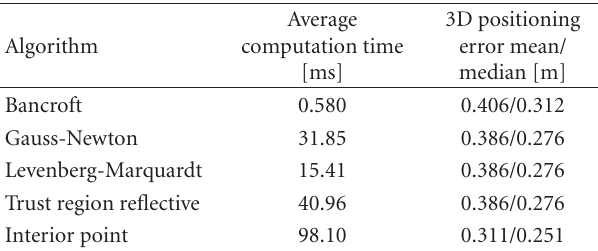
Table 1: Average 3D error and comutation times of various algo-